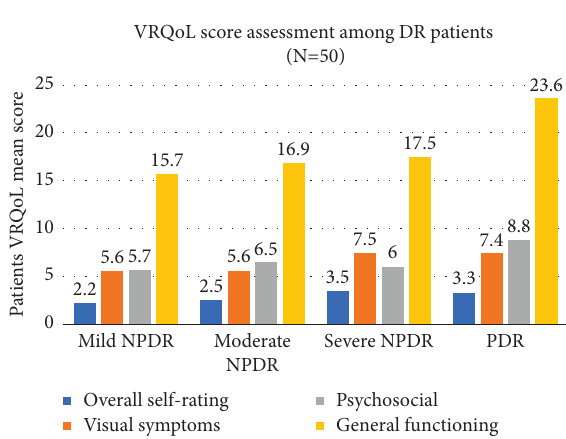
Figure 2: Graph illustrating VRQoL scores by ETDRS grades using patients’ worse eye, Eye CLINIC, Kenyatta National Hospital. DR: diabetic retinopathy; NPDR: nonproliferative diabetic retinopathy; PDR: proliferative diabetic retinopathy; VRQoL: vision-related quality of